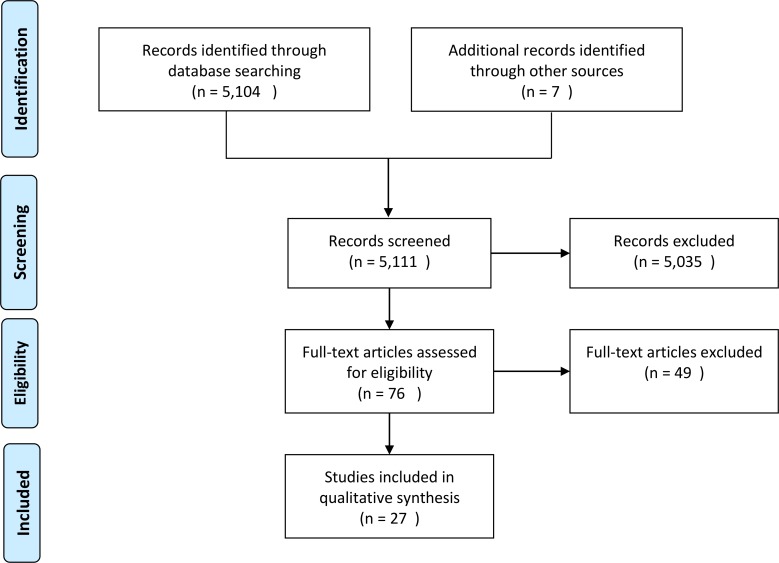
Study flow diagram.